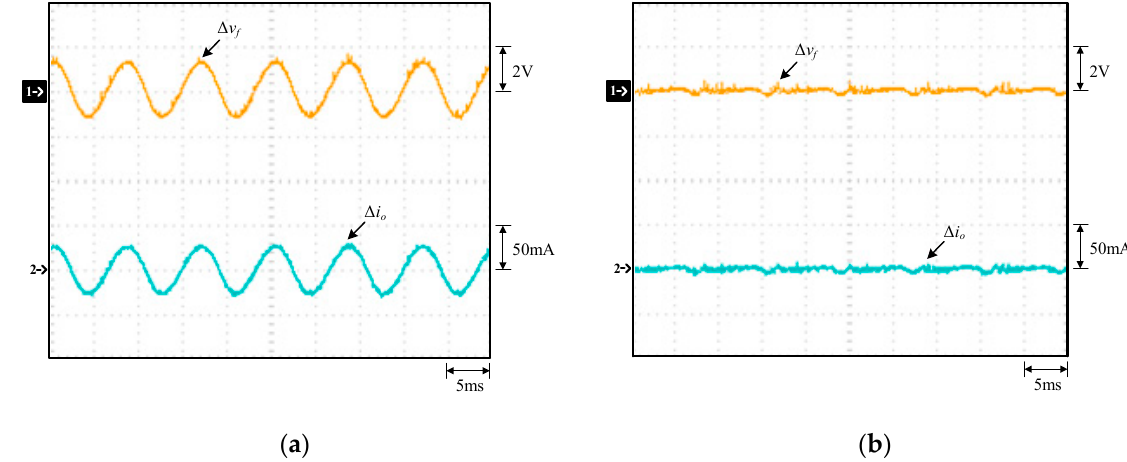
Figure 10. Waveforms under 220 V input voltage and 100% output load: ( a ) without; ( b ) with the proposed low-frequency current ripple improved: (1) Δ v f ; (2) Δ i o .